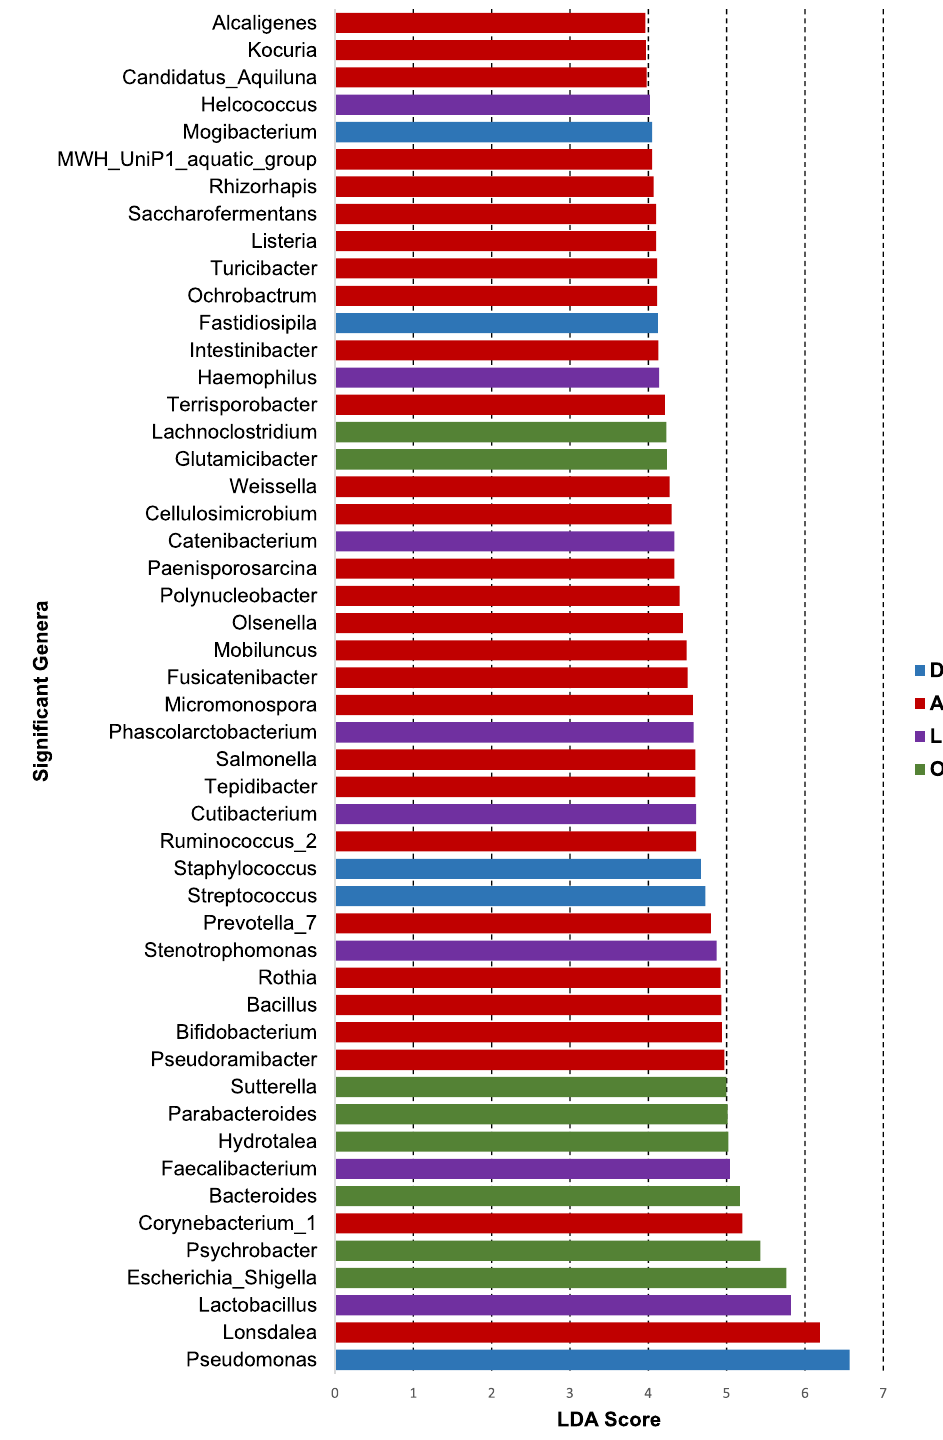
Figure 6. Significant features or bio markers that are differentially abundant in the endometrial lavage samples when grouped according to their geographical origin. 92 consensus differentially abundant genera were identified using LEfSe and DESeq2 algorithms, the top 50 of them are illustrated in the figure in ascending order of their LDA score. The bars, representing individual genera are color coded to indicate the sample group (geographical origin) in which they are most